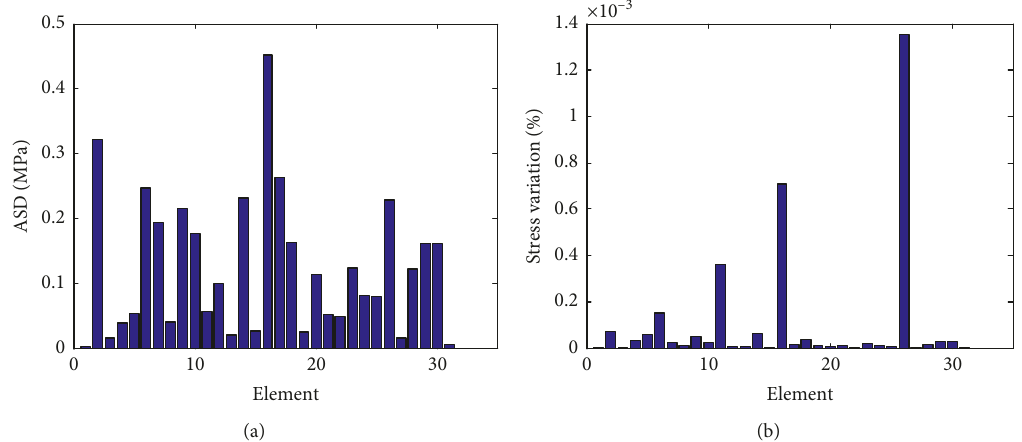
Figure 16: Multiple damages at elements 10 , 17 , and 26 using 3% noise-contaminated displacements and global-based approach of (a) ASD and (b) stress variation rate.